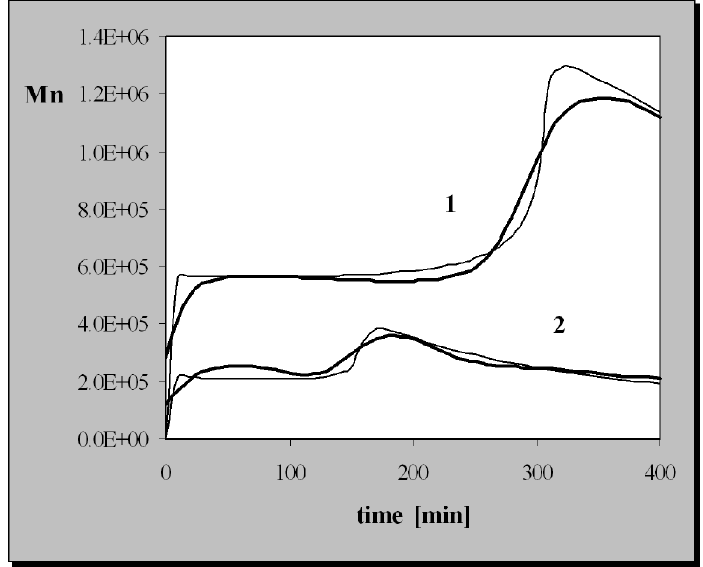
Fig. 17 Variation of number average molecular weight with time for: (1) T = 50 o C and I 0 = 15.48 mol/m 3 ; (2) T = 50 o C and I 0 = 100 mol/m 3 ; thick lines - predictions on MLP (3:9:3:3), thin lines - kinetic model [18],